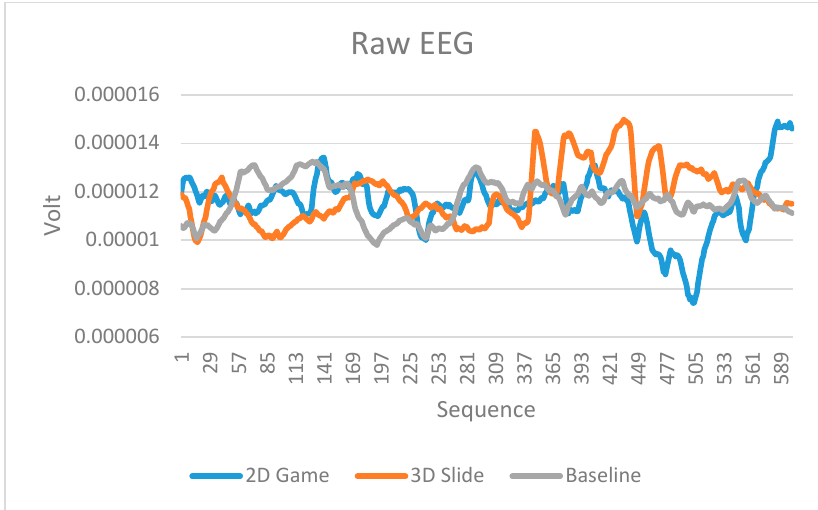
Figure 7. Raw EEG readings in the baseline, 2D game, and 3D slide.